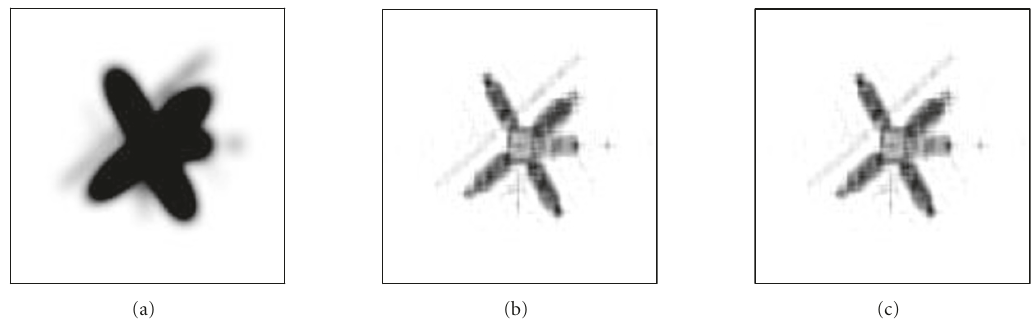
Figure 2: (a) Image blurred with Mask 4 and noise level 10 − 3 . 5 , (b) reconstructed images with inverse Toeplitz preconditioner and (c) with superoptimal preconditioner.